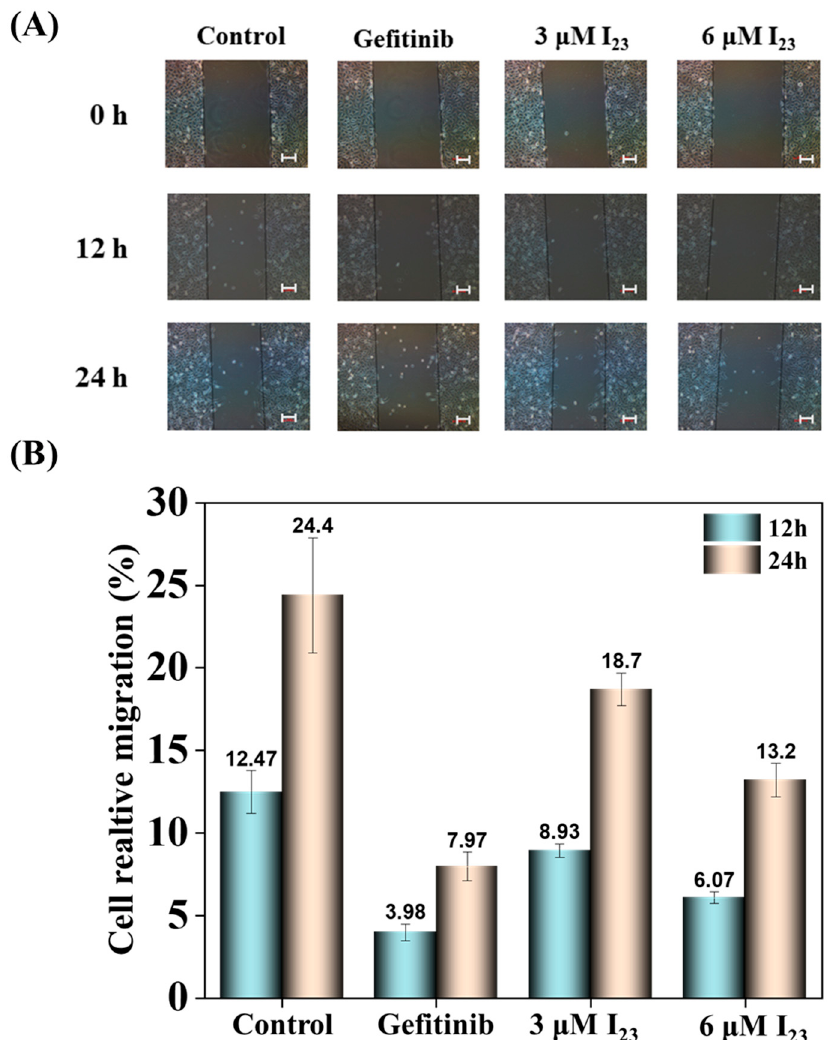
Figure 8. Cell migration assay showed that compound I 23 inhibited the migration of A549 cells. ( A ) ( A ) The cancer cells were incubated with 0 µ M, 3 µ M, 6 µ M compound I 23 , the 6 µ M gefitinib was The cancer cells were incubated with 0 μ M, 3 μ M, 6 μ M compound I 23 , the 6 μ M gefitinib was served served as the positive control. Scale bars are 100 µ m ( B ) the cell relative migration was calculated as the positive control. Scale bars are 100 μ m ( B ) the cell relative migration was calculated using the using the software.